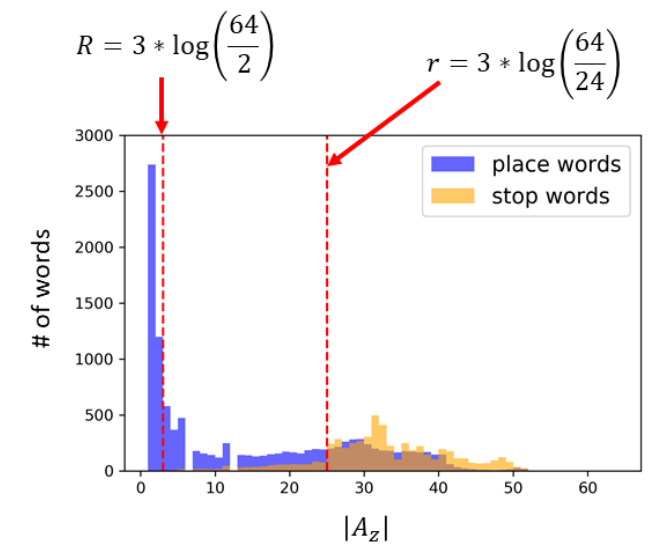
Figure 8. How the United Stated was divided into J = 64 areas.